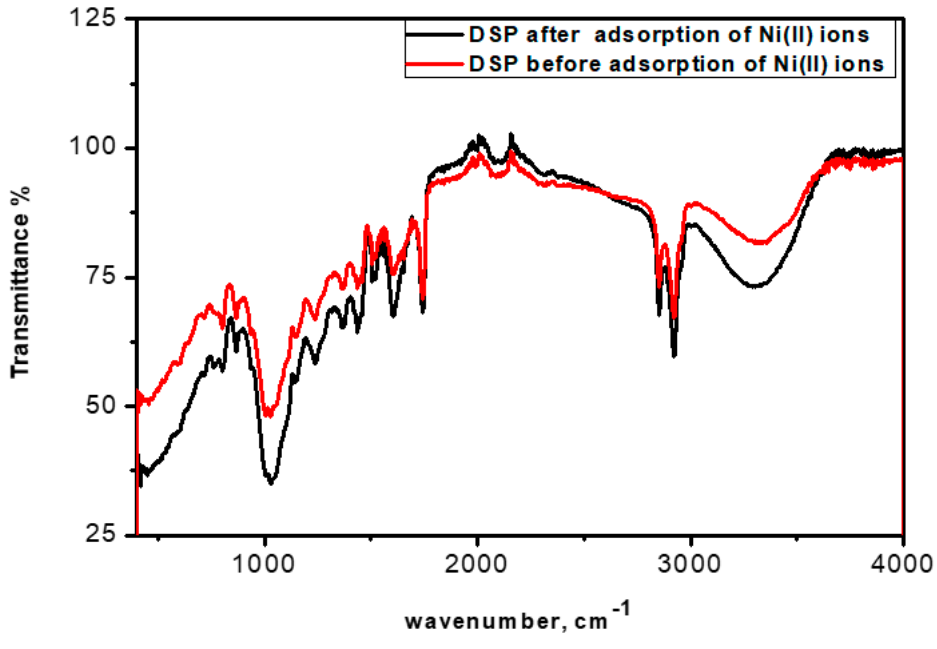
Figure 1. Attenuated total reflection-Fourier transform infrared spectrometer (ATR-FTIR) spectra for the date seeds powder (DSP) before and after Ni(II) ions adsorption process.